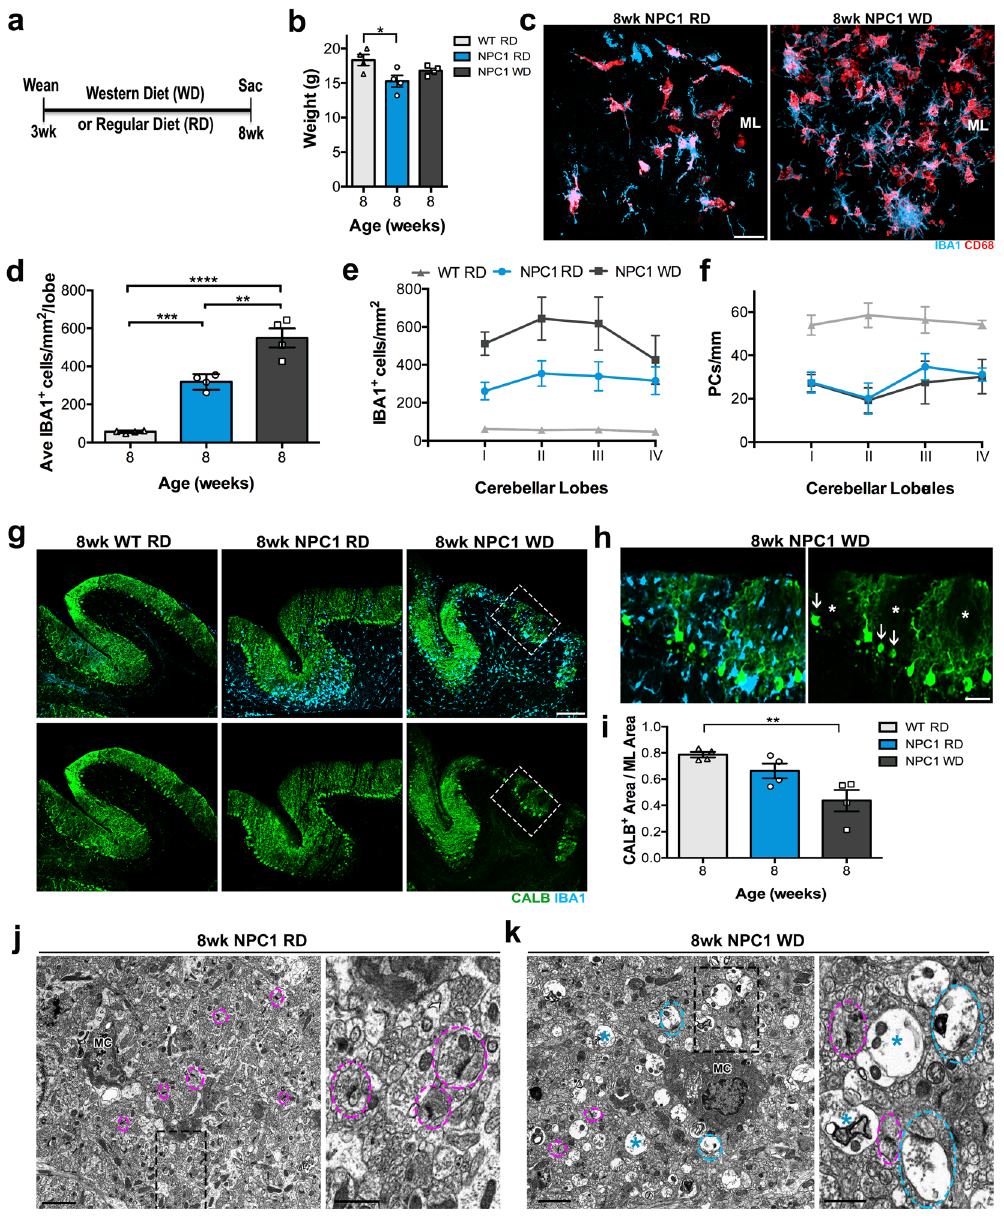
Figure 7. Npc1 nmf164 mice fed a WD have increased density of microglia and a more severe loss of PC dendrites at 8 weeks of age. ( a ) WT and Npc1 nmf164 mice were fed a WD or RD from wean (3 wks) for 5 weeks, and euthanized at 8 weeks of age. ( b ) The average weight of Npc1 nmf164 RD mice, was slightly less (but significant) than WT RD mice at 8 weeks of age. ( c ) Microglia density at the ML was evidently increased in Npc1 nmf164 WD mice when compared to Npc1 nmf164 RD. ( d ) Quantitative analysis confirmed that the average of microglia density per lobule was significantly increased in Npc1 nmf164 WD mice when compared to RD-fed mice. ( e ) Density of microglia per cerebellar lobule (I to IV) in Npc1 nmf164 mice fed the RD or WD compared to WT RD mice. ( f ) Density of PC per cerebellar lobule (I to IV) in Npc1 nmf164 mice fed the RD or WD compared to WT RD mice. ( g ) Low-magnified images showing cerebellar lobules I and II from WT RD, Npc1 nmf164 RD and Npc1 nmf164 WD cerebella immunostained with CALB (green) and IBA1 (cyan). ( h ) High magnified images from inserts in ( g ) showing the severity of CALB + dendrites degeneration in Npc1 nmf164 mice fed the WD. The ( * ) symbols show spaces where CALB + dendrites have degenerated, arrows show PC somata without dendrites. ( i ) Quantitative analysis of the ratio between CALB + area to the total area of the ML showed a significant decrease in the cerebellar lobules I and II from Npc1 nmf164 WD mice when compared to WT RD mice. ( j ) Electron micrograph and magnified inset showing microglia process (MC) and normal synapses (pink circles) in Npc1 nmf164 RD. ( k ) Transmission electron micrograph and magnified inset showing microglial cell (MC) and swollen presynaptic terminals forming synapses (blue circles) or not (blue * ) in Npc1 nmf164 WD. Data are presented as mean ± SEM, n = 4 per group, * P < 0.05, ** P < 0.01, *** P < 0.001. Scale bars: ( d ) 30 μ m, ( g ) 150 μ m, ( h ) 40 μ m, ( j , k ) 2 μ m, insets 1 μ